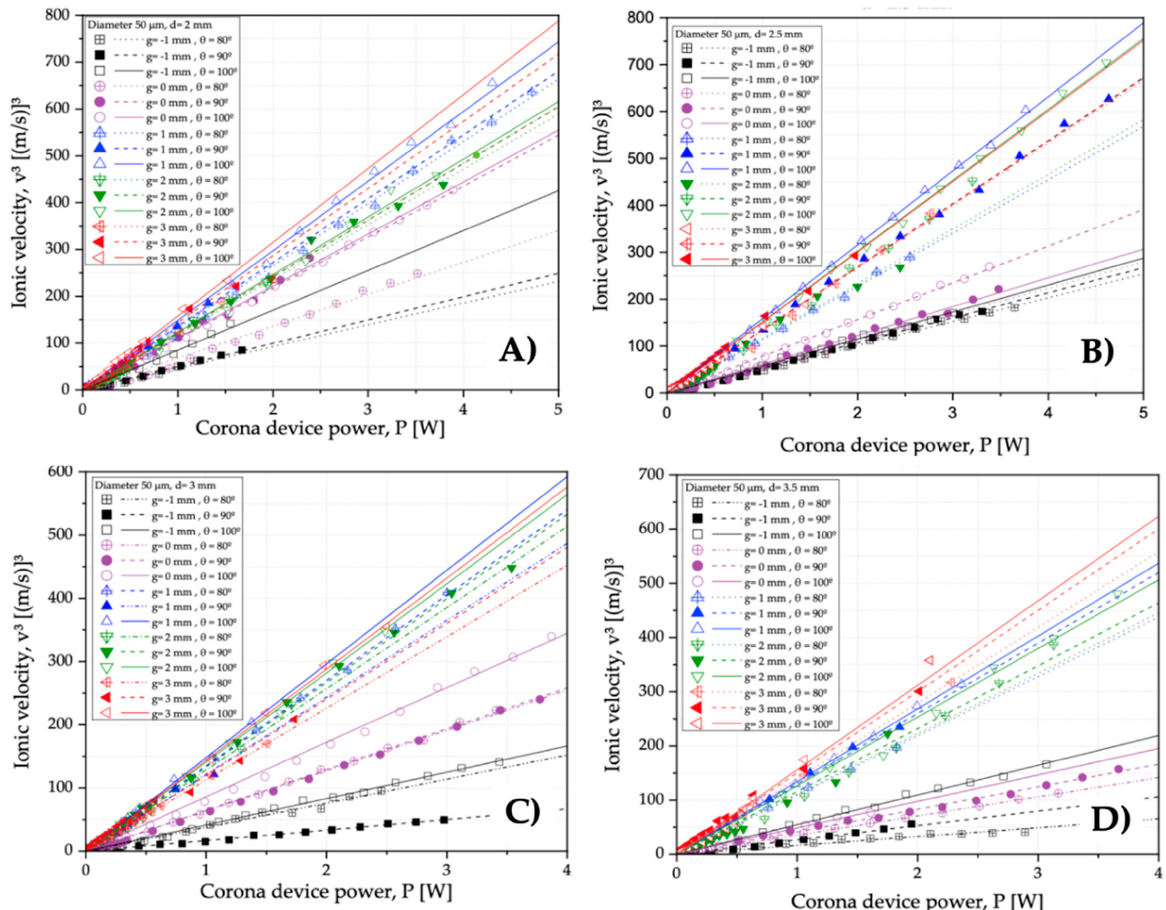
Figure 9. Linear ratio between the electrical power ( P ) and velocity cubed v 3 for diverse designs with wire of 50 μ m considering gap of ( A ) 2, ( B ) 2.5, ( C ) 3, and ( D ) 3.5 mm.